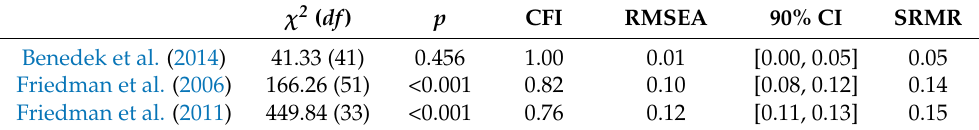
Figure 7. Reanalysis of Friedman et al. (2011). Inh = inhibition; Upd = updating; Shf = shifting; WIQ = WAIS IQ. Table 3. Model fit